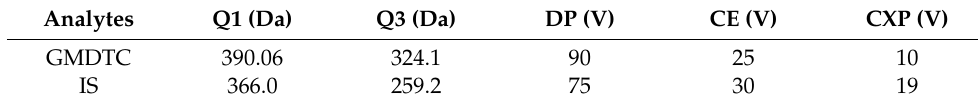
Table 6. MS parameters for the GMDTC and metolazone